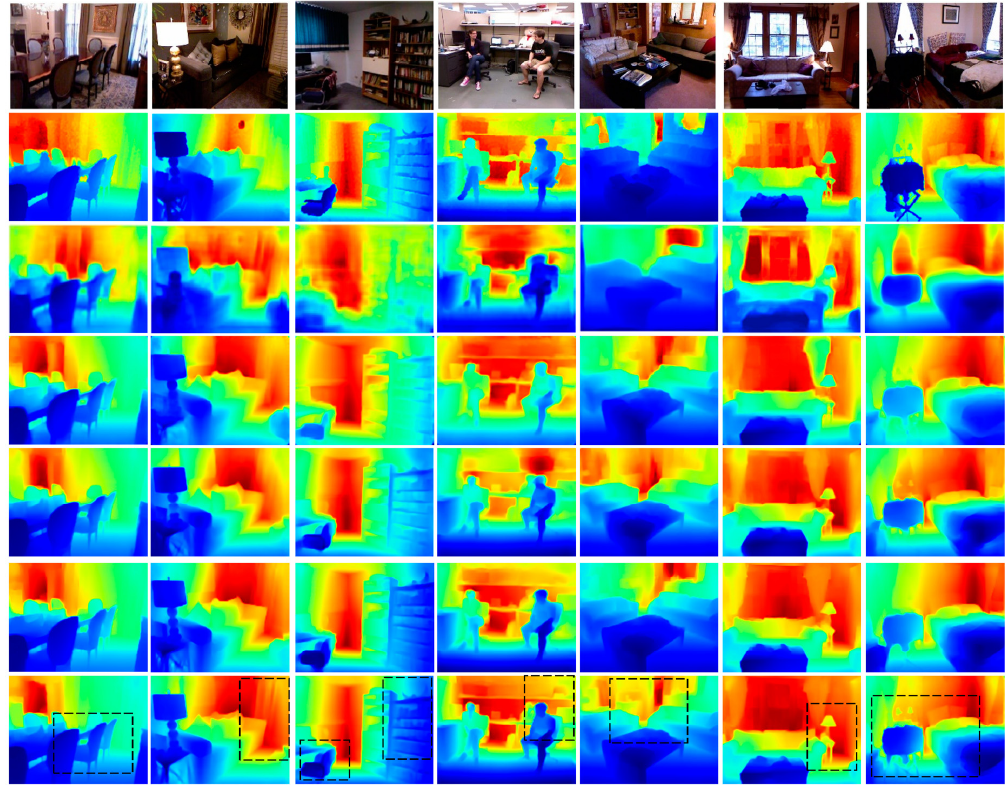
Figure 7. Qualitative evaluations on NYU-Depth-V2. Rows from top to bottom: original RGB images, ground truth depth maps, Laina et al. [31], Alhashim et al. [17], Hu et al. [22], Chen et al. [20], and the proposed method. Regions in black boxes highlight the better-predicted results. Color indicates depth, where red is far and blue is close. Net-154 encoder, with some quantitative comparisons in Figure 8 and more qualitative